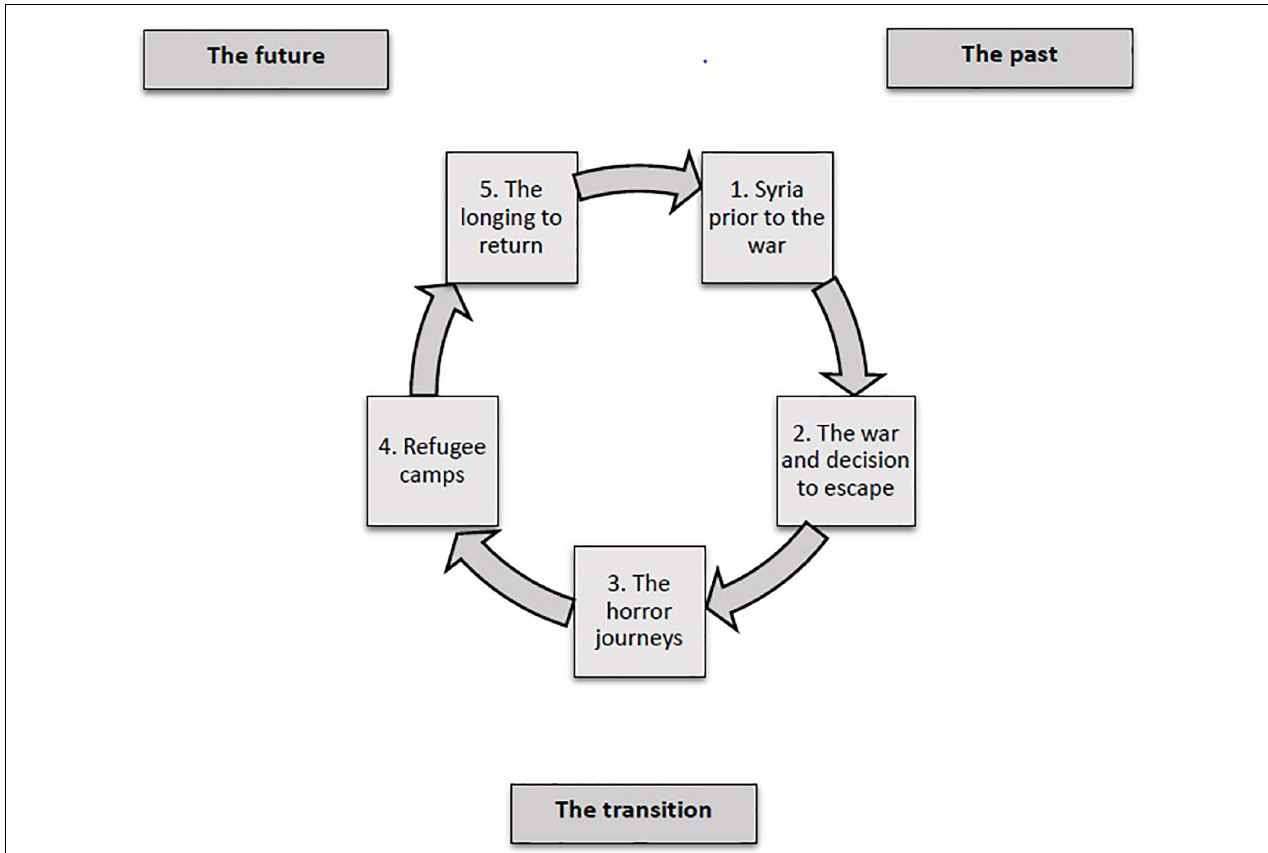
FIGURE 1 | Themes of Syrian refugee women’s